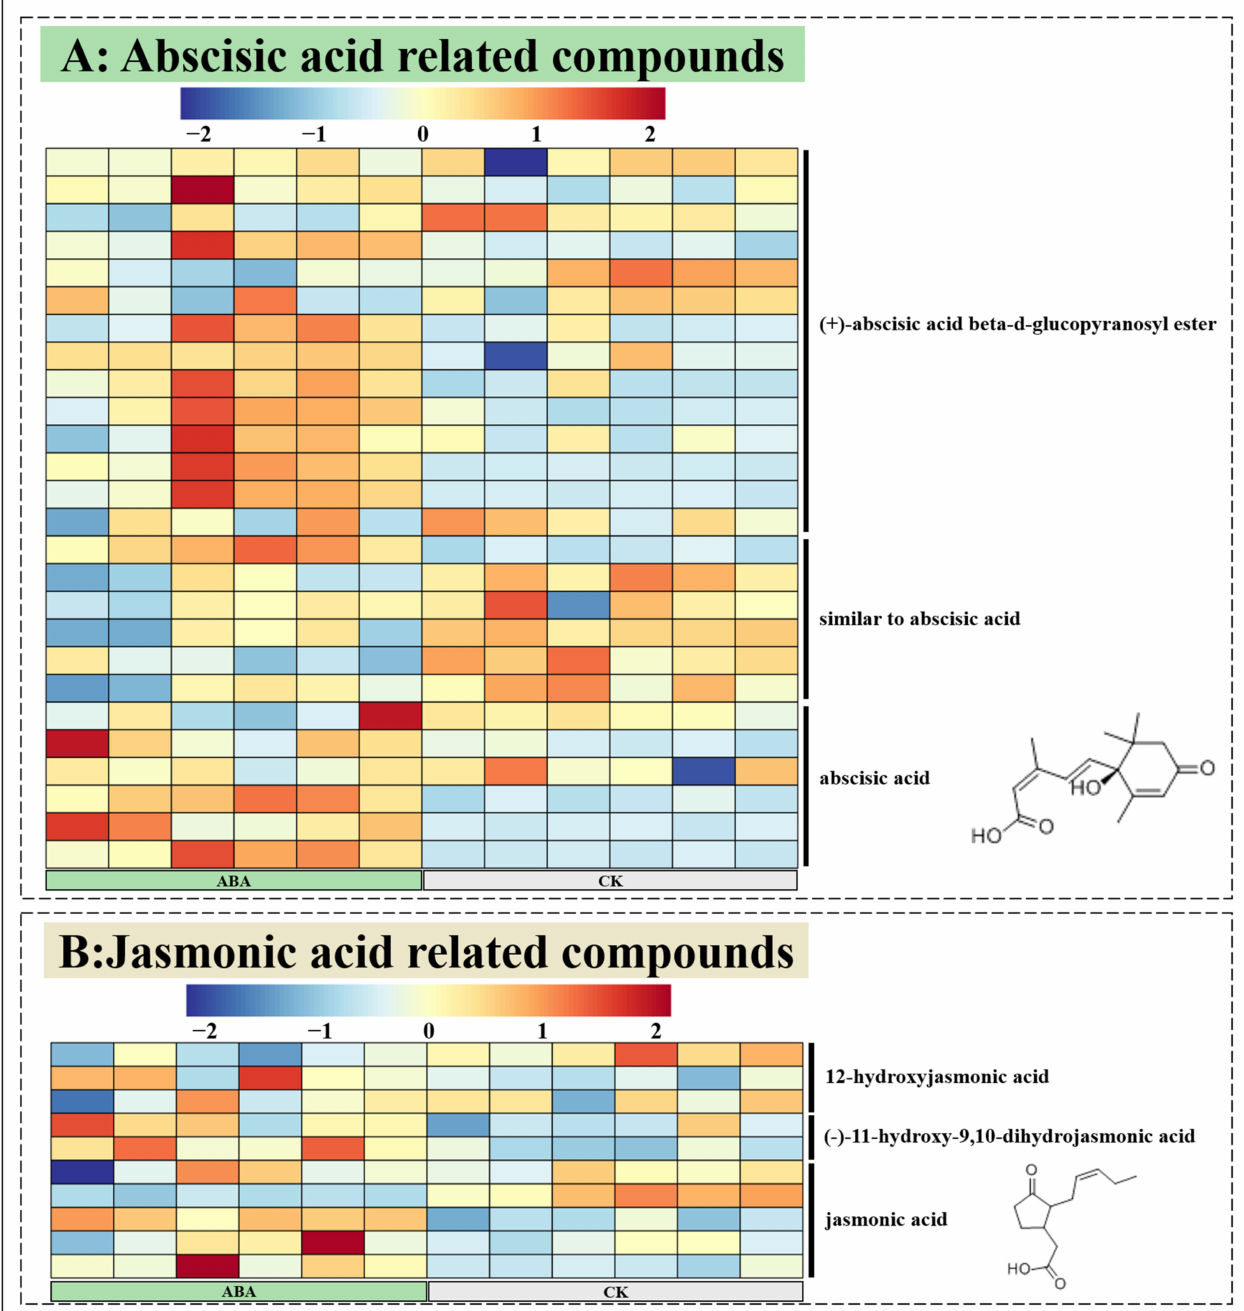
Figure 9. A heatmap of the relative compounds of abscisic acid and jasmonic